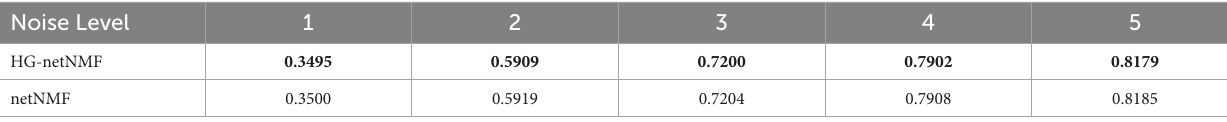
TABLE 2 The objective function values of the two algorithms were compared on a simulation dataset with a small sample